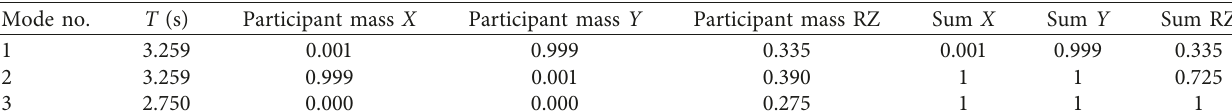
Table 5: Five columns frame: periods and participant masses (translation X , translation Y , and rotation Z in the vibration modes). Mode no.